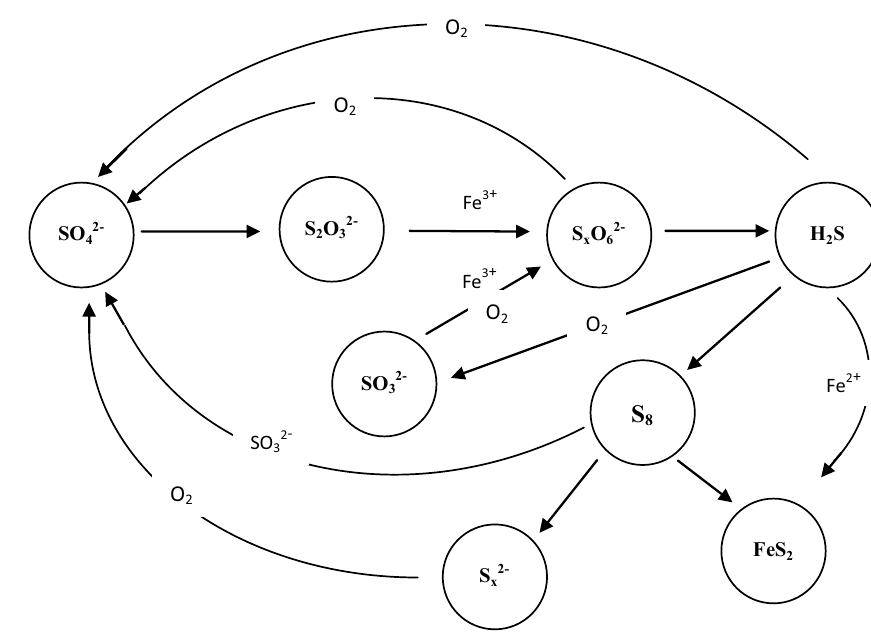
Fig. 1 Oxidation reduction reac- tions in sulfur